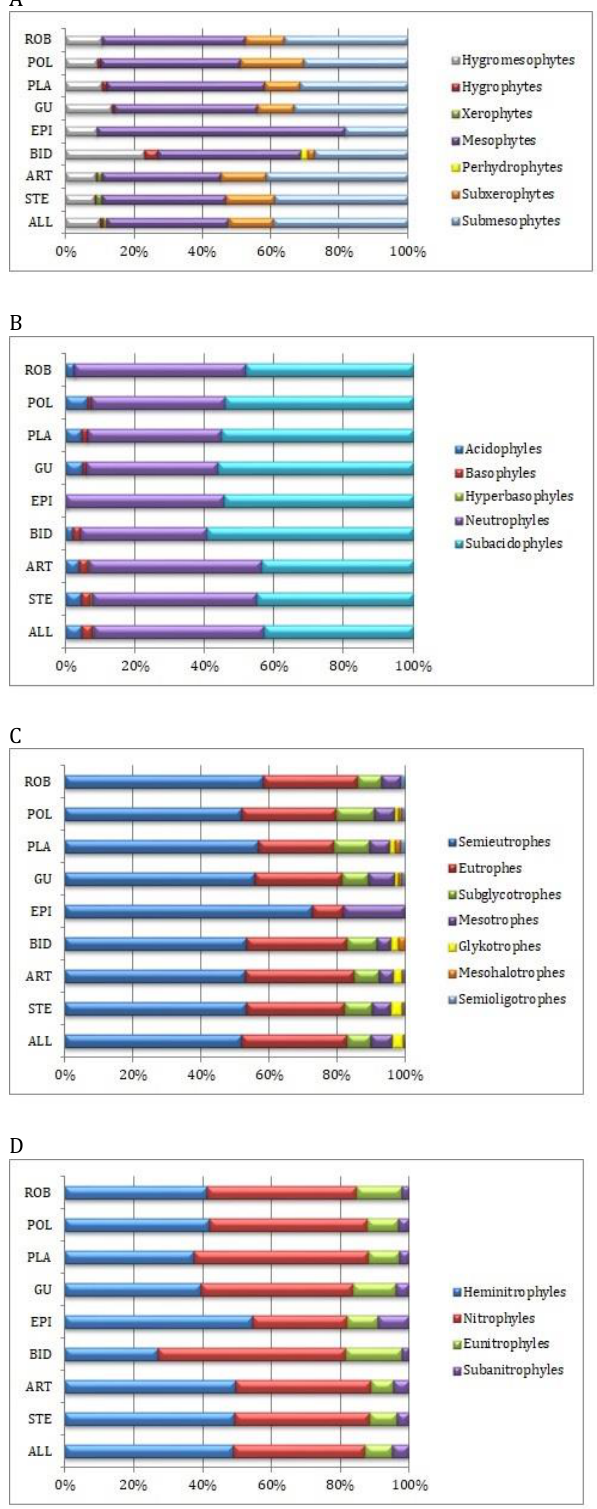
Fig. 3. Distribution of alien species in ruderal vegetation by: A - soil humidity, B – acidity, C – salt regime, D - nitrogen